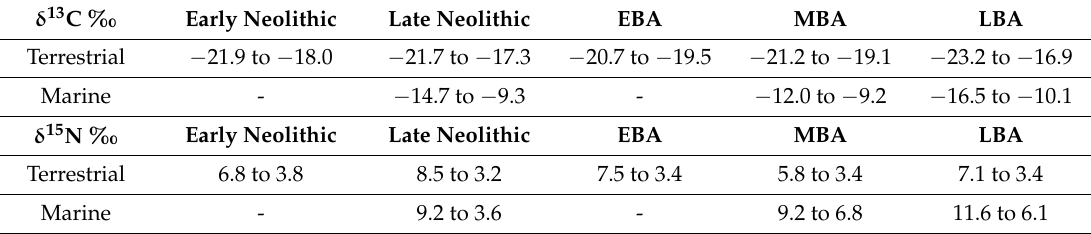
Table 6. Ranges of the archeological fauna for the studied periods as reported in the